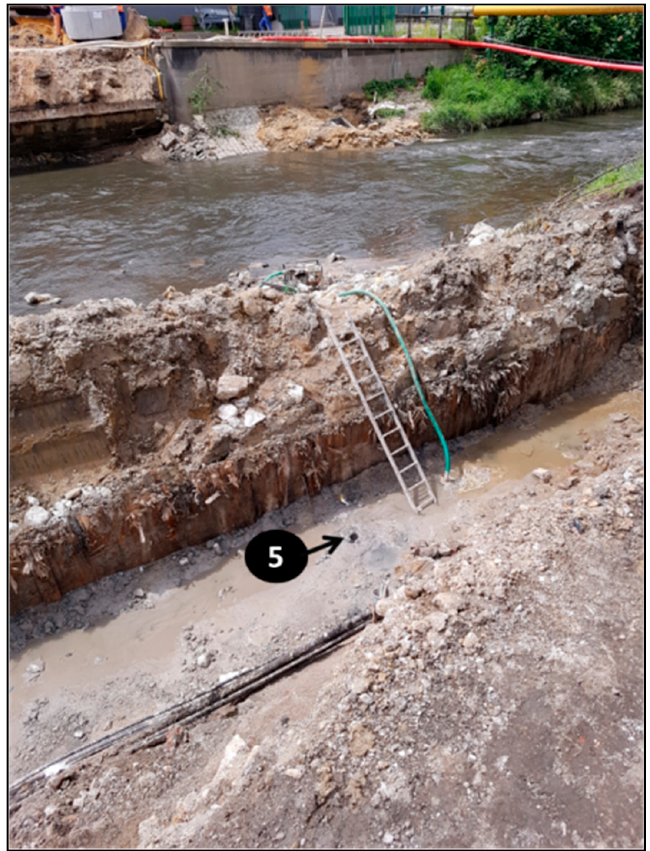
Figure 7. Location of foundation borehole.